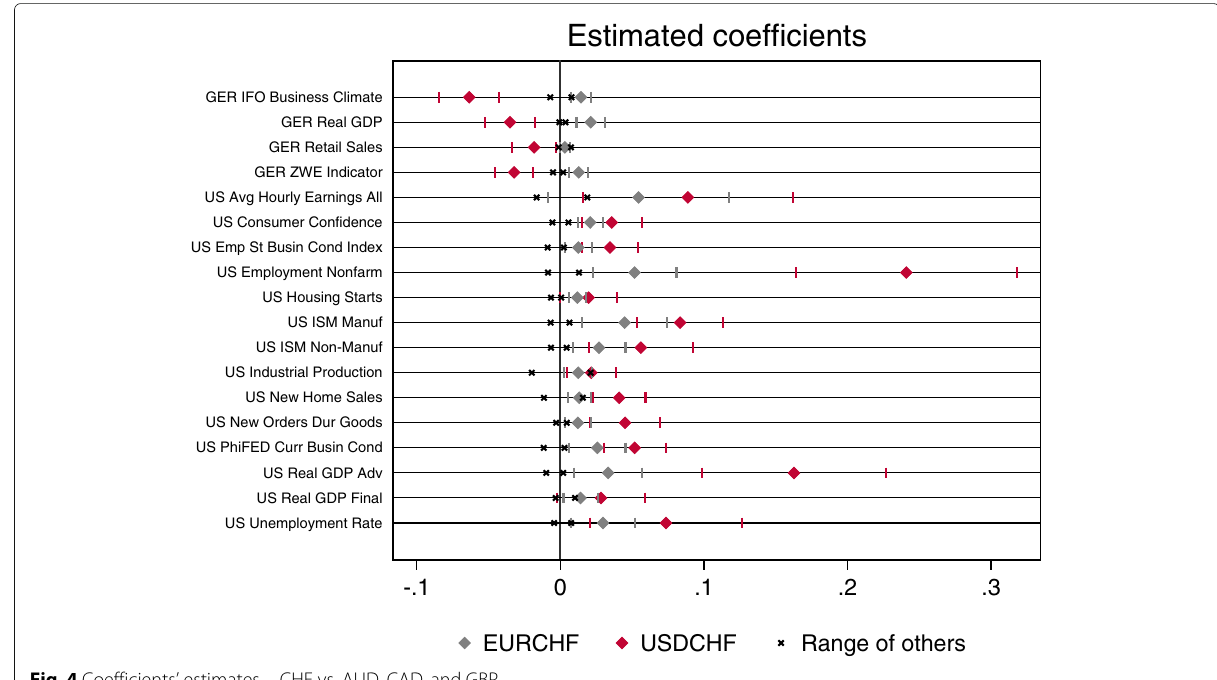
Fig. 4 Coefficients’ estimates—CHF vs. AUD, CAD ,and GBP two periods is extremely impressive. Whereas domes- tic surprises tend to be significant (and bear the right sign) already in the pre-crisis period, most foreign vari- ables turn significant only when the crisis occurs. This pattern is clearly visible in both the EURJPY and USD- JPY exchange rates. The most extreme individual case is